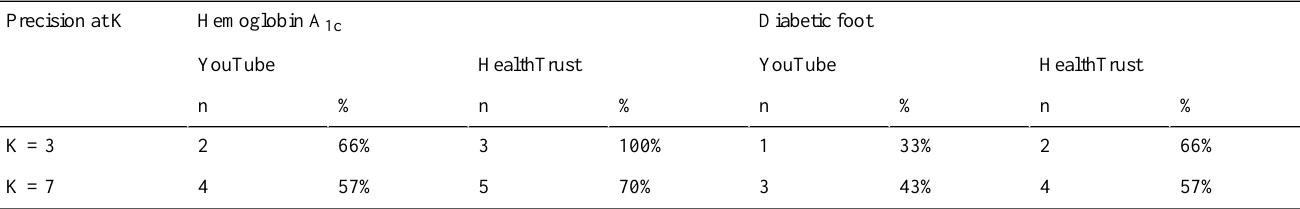
Table 3. Precision at K for videos evaluated by professionals retrieved by HealthTrust and YouTube